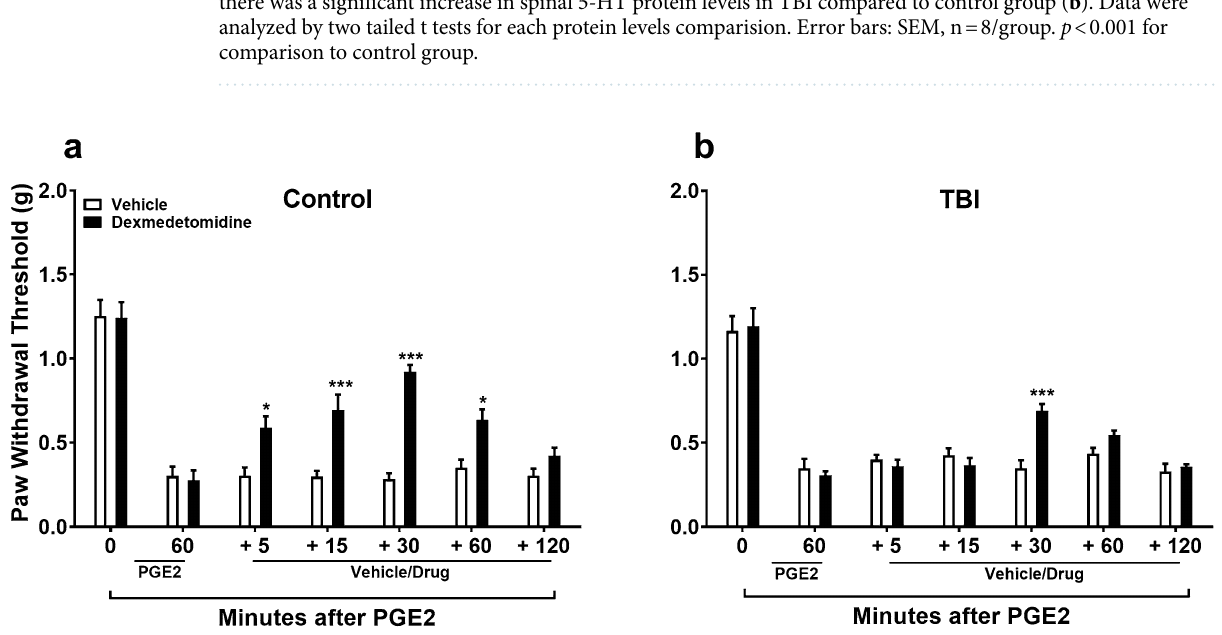
Figure 5. Assessment of norepinephrine signaling and analgesic response after mild TBI. Lumbar spinal intrathecal administration of the α2 adrenoceptor agonist dexmedetomidine (DEX) produced significant analgesia in control naïve male mice ( a ) when given after plantar PGE 2 -induced sensetization. DEX treatment had markedly reduced analgesic response to PGE 2 -induced sensetization when given 4 weeks after mild TBI ( b ). Data were analyzed by two-way repeated measures ANOVA using the Sidak method to correct for multiple comparisons. * p < 0.05, ** p < 0.01, *** p < 0.001 indicates significant difference between vehicle and drug treatment groups. Error bars: SEM, n =